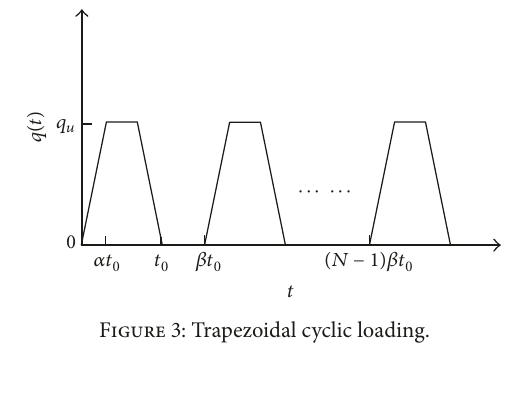
Figure 3: Trapezoidal cyclic loading.